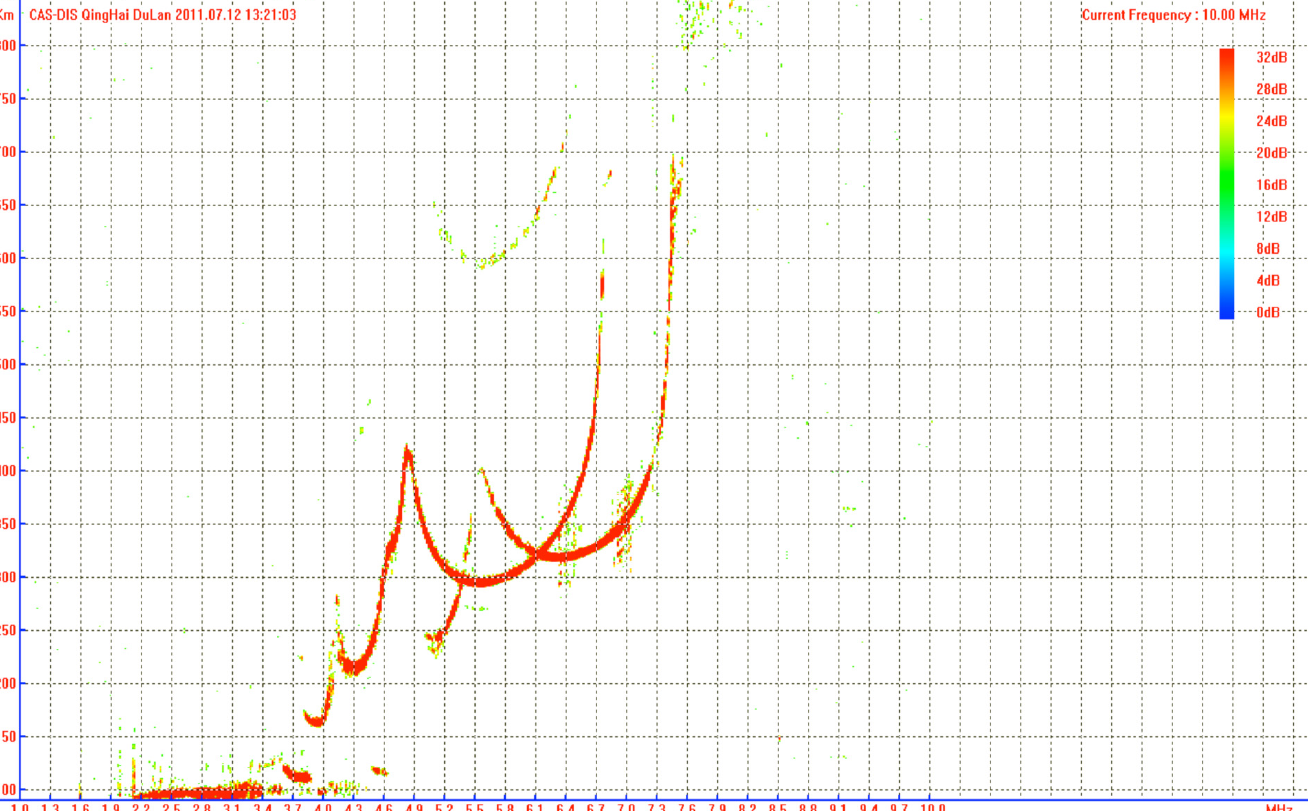
Figure 10. Test result of the CAS-DIS on July 12, 2011, for the Qinghai Dulan station (16-bit complementary code).